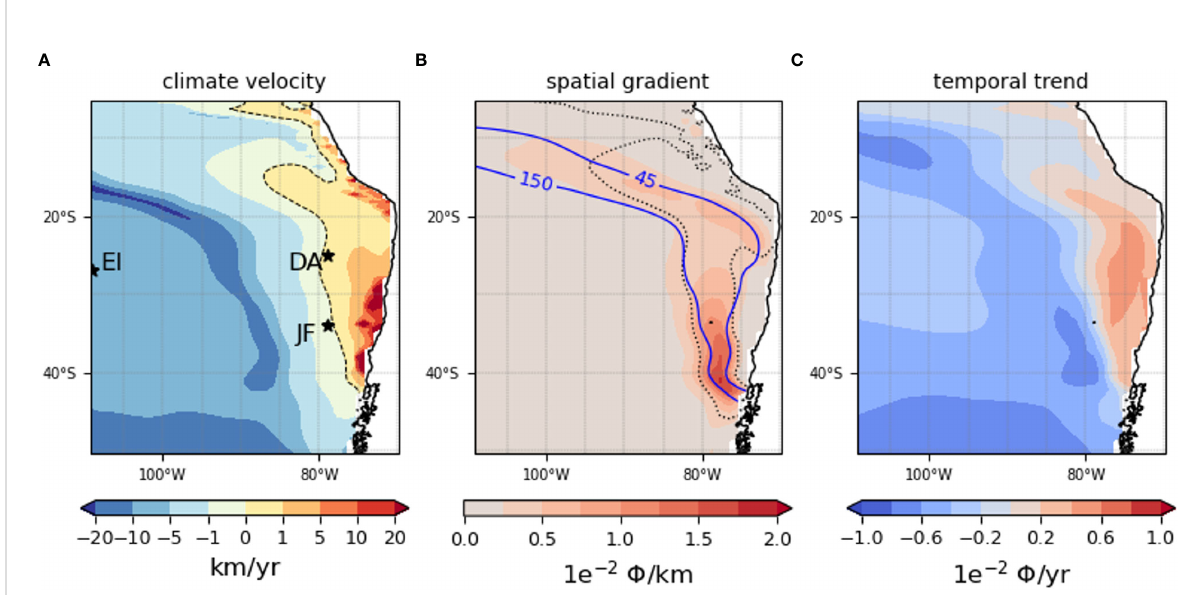
FIGURE 3 Climate velocities, spatial gradient and temporal trend of the Metabolic Index F of the model species at 200m over 2006-2100. For climate velocities (A) , the dashed line is where CV F model = 0 km.yr -1 . For the spatial gradient (B) , the dotted line delimits the region for which |CV|< 1 km.yr -1 . The blue isolines represent the 45 (OMZ) and 150 (oxygenated waters) oxygen isocontours in mmol.m -3 . (C) are the temporal trend. The dark stars represent Juan Fernandez (JFA), the Desventuradas Archipelagos (DA) and Easter Island